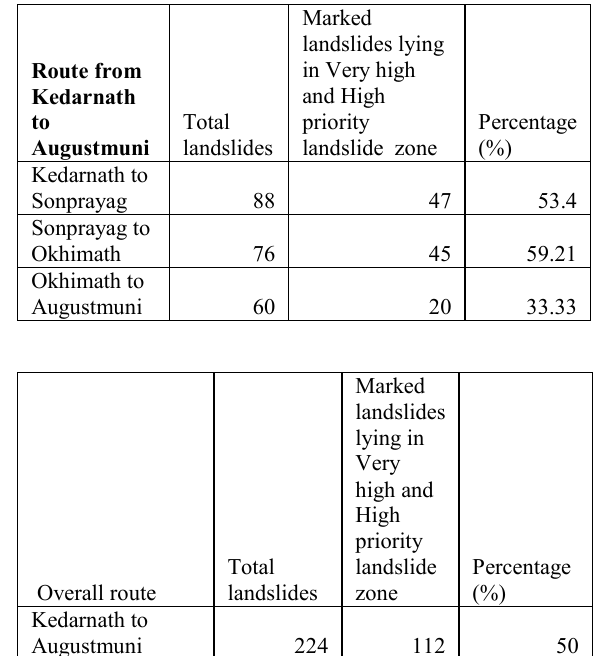
Table 1. Validation of Landslide Hazard Zonation map 7.